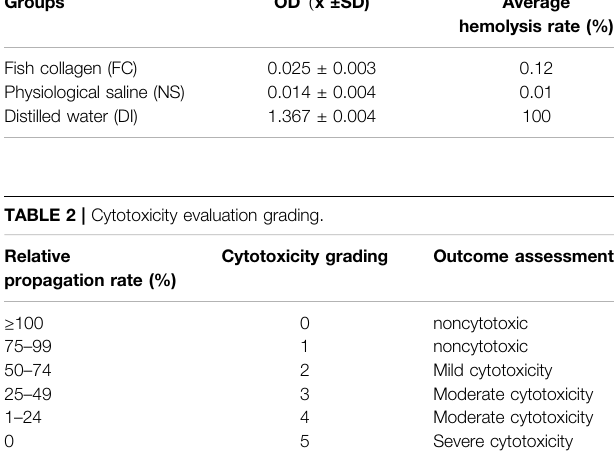
TABLE 1 | OD and hemolysis rate in each group ( n = 10, per group). Groups